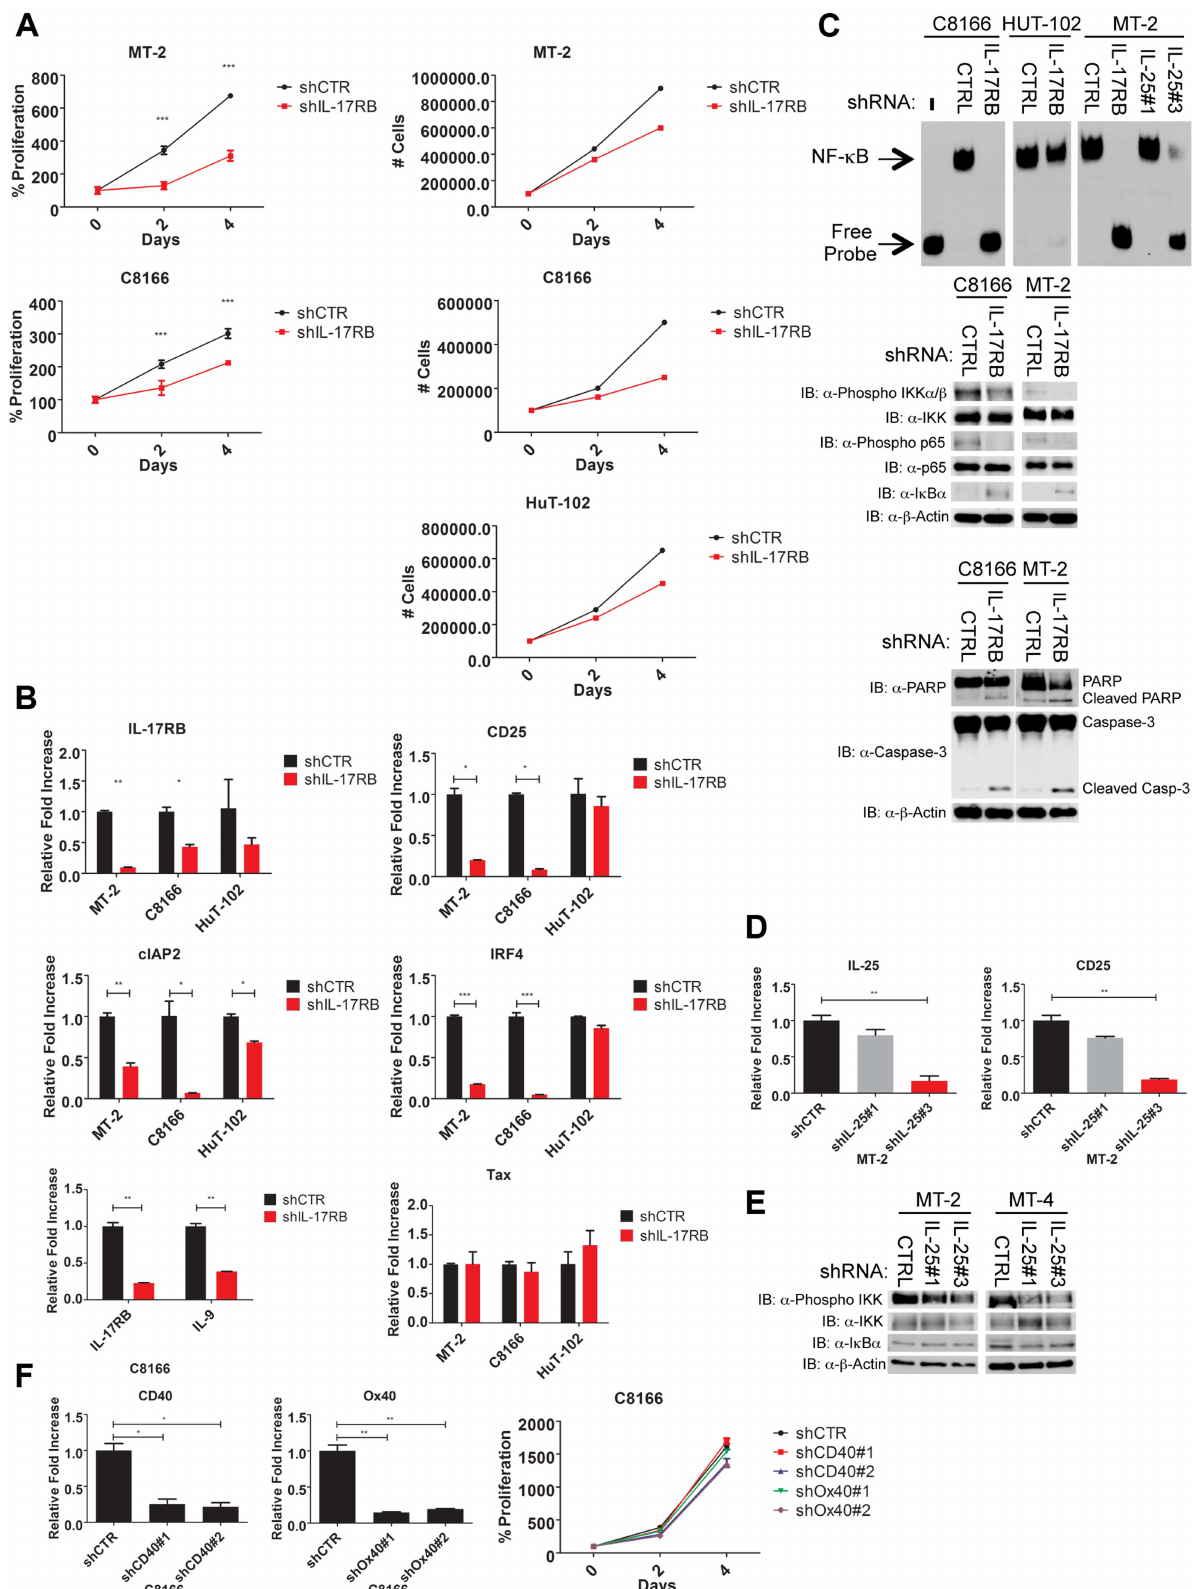
Figure 5. IL-17RB and IL-25 are essential for NF- k B activation and survival of HTLV-1 transformed cells. ( A ) Proliferation/viability assay of MT-2 and C8166 cells transduced with lentiviruses expressing control or IL-17RB shRNA using CellTiter-Glo (left). Cell counts of MT-2, C8166 and HUT-102 cells transduced with control or IL-17RB shRNA. ( B ) qRT-PCR of indicated mRNAs in HTLV-1 transformed cell lines transduced with PLOS Pathogens |